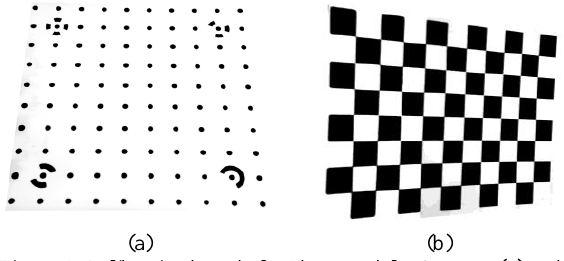
Figure 4. Calibration boards for Photomodeler Scanner (a) and FAUCCAL and Camera Calibration Toolbox (CCT)